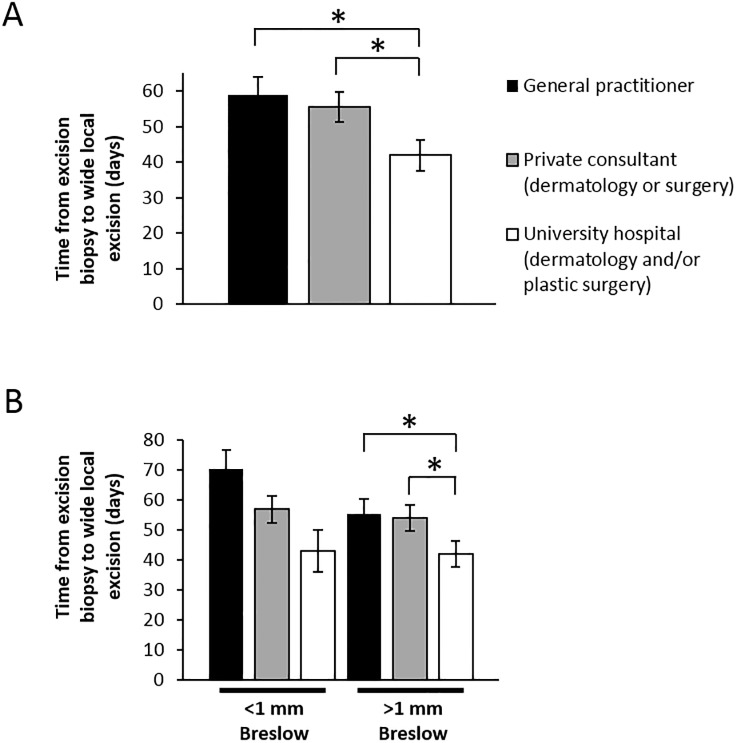
University level melanoma care show less inter-surgical delay.A) Time from excision biopsy until wide local excision regardless of Breslow tumor thickness. B) Time from excision biopsy until wide local excision stratified according to Breslow tumor thickness. *p<0.05.